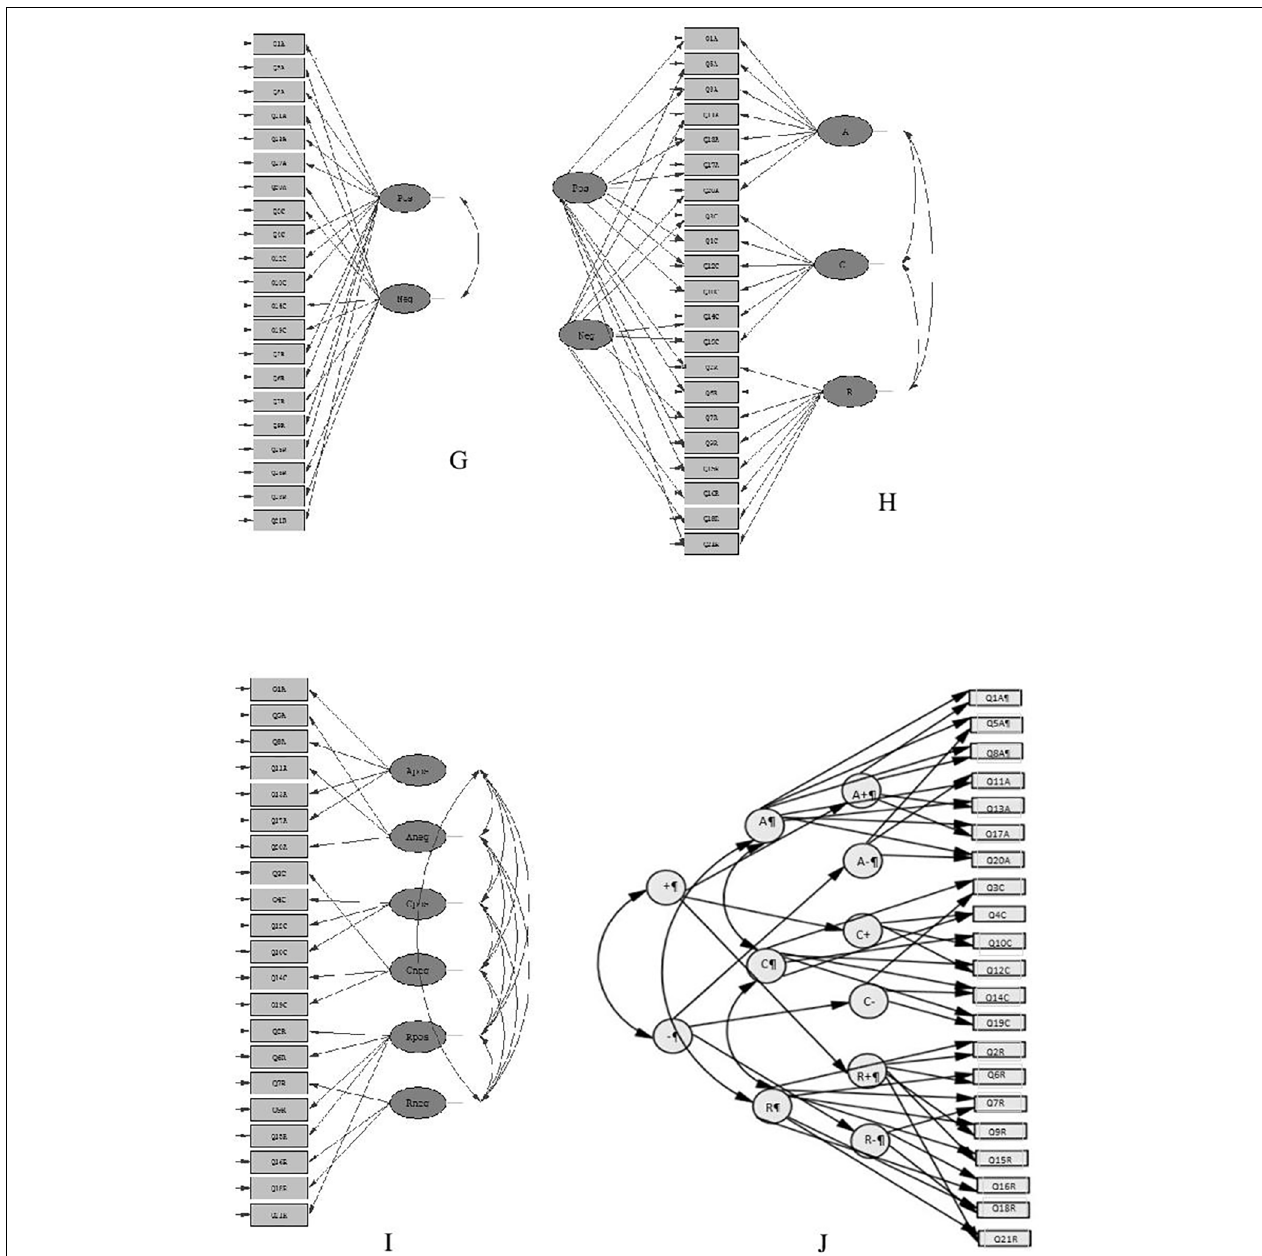
FIGURE 1 | Suggested factor structures (A–J) to scales measuring basic psychological need